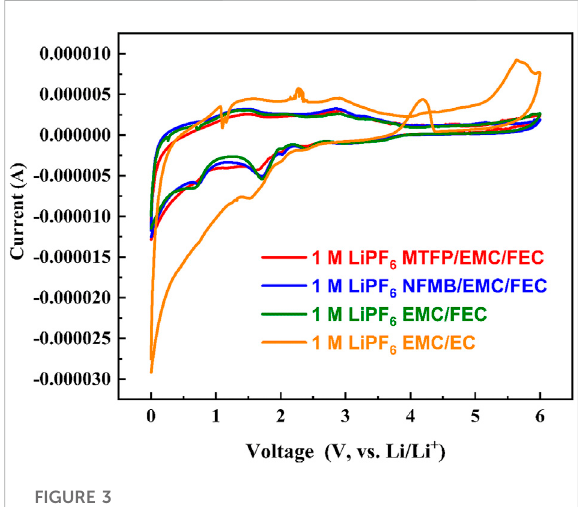
FIGURE 3 Cyclic voltammetry curves of electrolytes at a scan rate of 0.1 mV s − 1 at 25 ° C on Li/SS coin